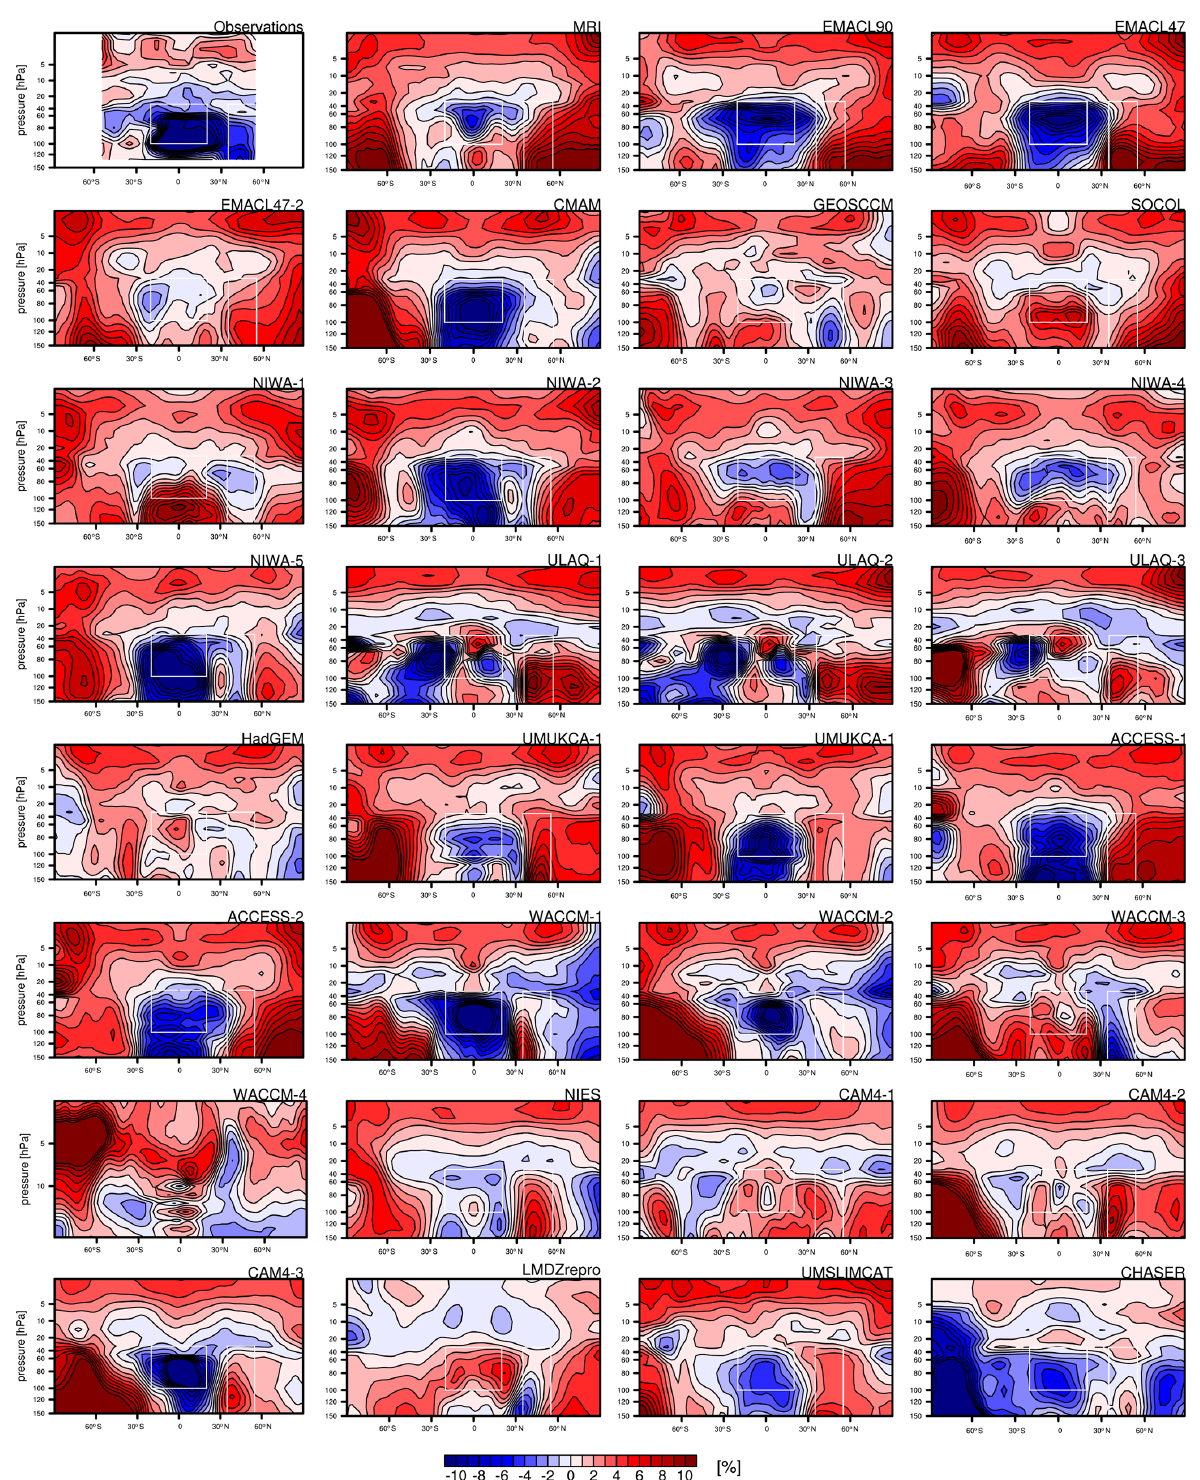
Figure 1. Latitude–pressure cross-section of the relative ozone trend over the period 1998–2018 for the observational dataset BASIC SG and for all CCMI REF-C2 simulations. Boxes illustrate the regions selected to integrate ozone in the LS for trend comparisons later in this